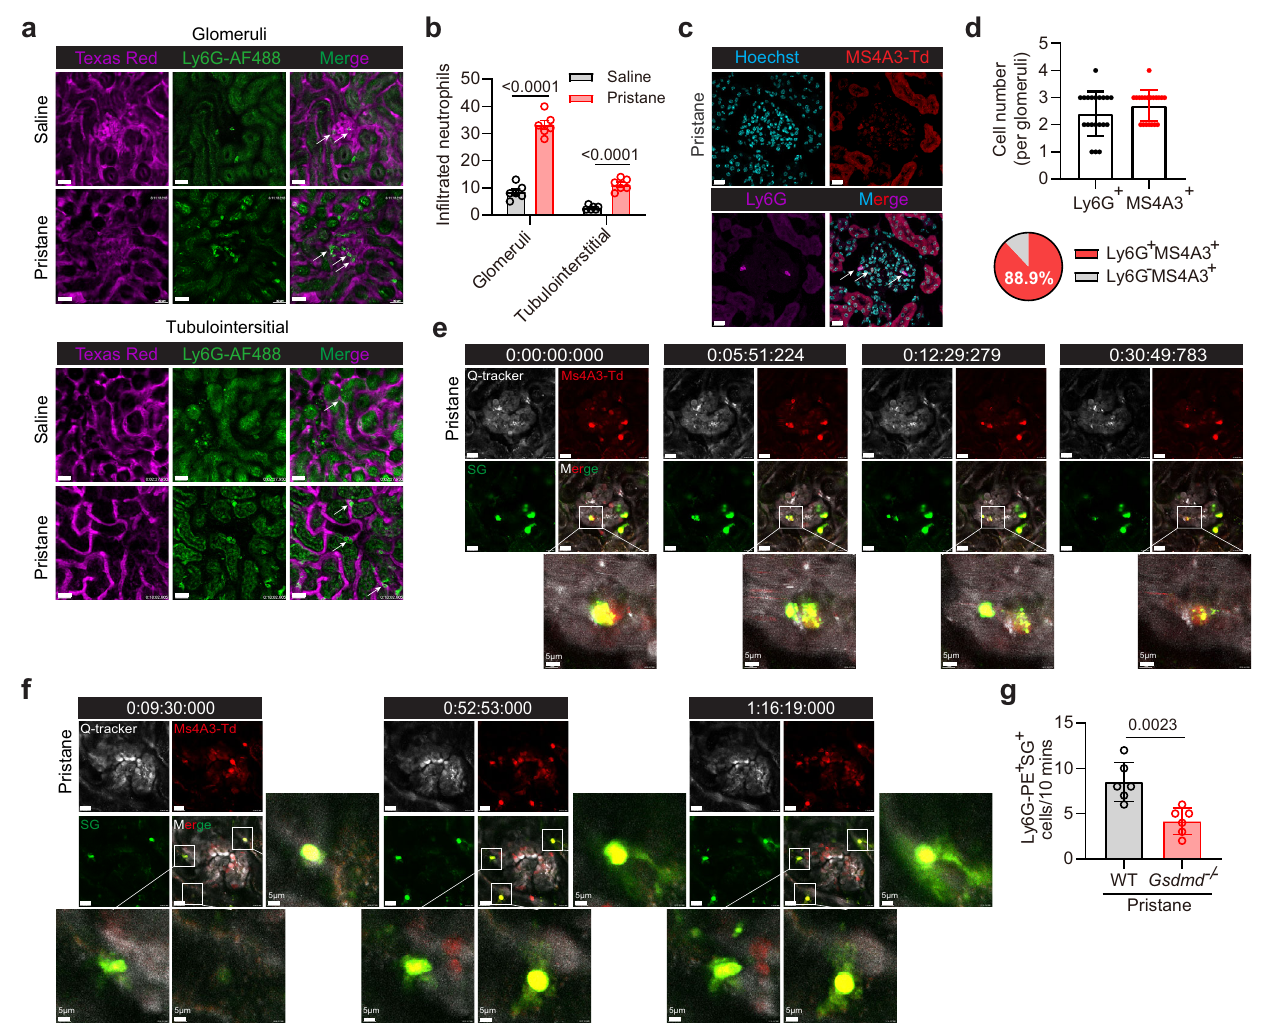
Fig. 2 | Intravital renal microscopy reveals neutrophil cell death in live lupus mice. a Two photon intravital imaging analysis of in fi ltrated neutrophils (Ly6G- AF488) in renal blood vessels (Texas Red) of live mice (glomeruli and tubu- lointerstitial) after saline or pristane treatment. Scale bar, 30 μ m. b Quantitative analysis of in fi ltrated neutrophils in glomeruli and tubulointerstitial of mice after saline or pristane treatment. n =6 mice. c Immuno fl uorescence staining of Ly6G in glomeruli from Ms4a3-tdTomato ( Ms4a3-Td ) mice after pristane treatment. Scale bar, 30 μ m. d Quantitative analysisofLy6G + and Ms4a3-tdTomato + cellnumbersin each glomerulus and percentage of Ms4a3-tdTomato + Cells. Representative of three independent experiments, and each point represents one glomerulus with